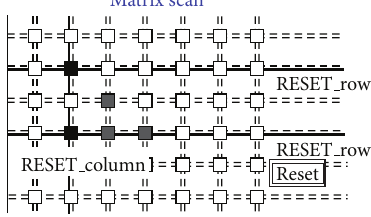
Figure 10: First reset on the enabled column.